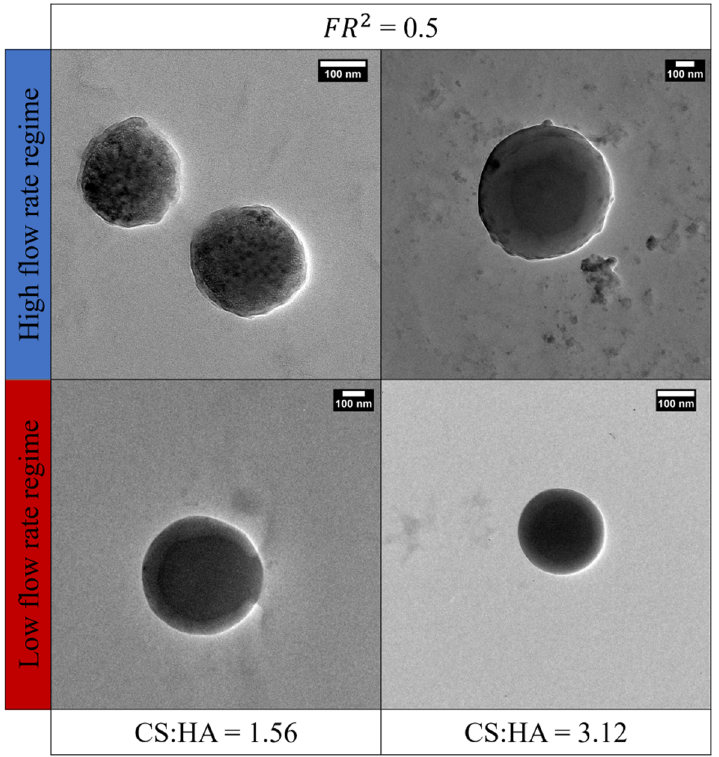
Figure 5. NPs’ morphologies obtained by TEM characterization for different CS:HA weight ratios and flow rate regimes and at constant FR 2 . Sizes range from: upper left 38.57 ± 14.31 nm; upper right 178.63 ± 171.47 nm; lower left 471.86 ± 67.28 nm; lower right 150.33 ± 112.01 nm (size distribution histograms are displayed in Figure S5 of the Supplementary Material).